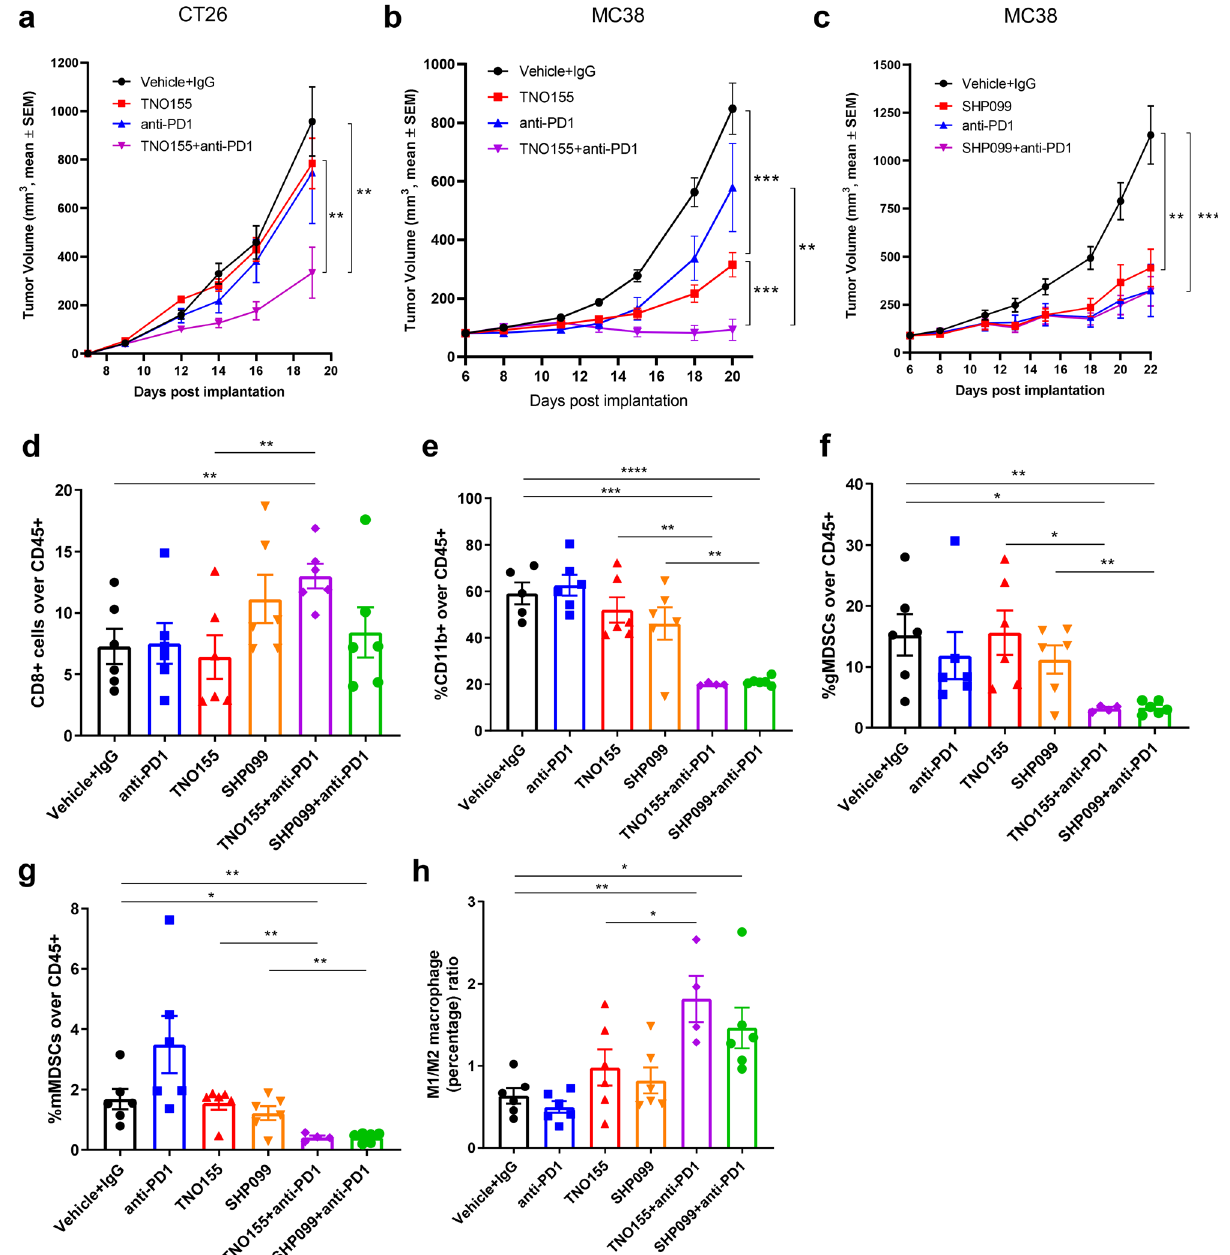
Figure 9. SHP2 inhibition displays combination benefit with PD1 blockade. ( a ) Tumor growth curve (expressed as tumor volume) of subcutaneous CT26 tumors in CT26 syngeneic mice with different treatments. TNO155: 20 mg/kg, PO, BID; Anti-PD1: 10 mg/kg, IP, QW. ( b , c ) Tumor growth curve (expressed as tumor volume) of subcutaneous MC38 tumors in MC38 syngeneic mice with different treatments. Mice were treated with Vehicle + IgG, anti-PD1, TNO155 and TNO155 + anti-PD1 in ( b ); Mice were treated with Vehicle + IgG, anti-PD1, SHP099 and SHP099 + anti-PD1 in ( c ); TNO155: 20 mg/kg, PO, BID; SHP099: 100 mg/kg, PO, QD; Anti-PD1: 10 mg/kg, IP, QW. ( d ) Flow cytometry analysis of the percentage of CD8+ T cells over CD45+ immune cells in MC-38 syngeneic model. ( e ) Flow cytometry analysis of the percentage of CD11b+ myeloid cells over CD45+ cells in MC-38 syngeneic model. ( f ) Flow cytometry analysis of the percentage of gMDSCs over CD45+ cells in MC-38 syngeneic model. ( g ) Flow cytometry analysis of the percentage of mMDSCs over CD45+ cells in MC-38 syngeneic model. ( h ) Flow cytometry analysis of the percentage ratio of M1 macrophage over M2 macrophage in MC-38 syngeneic model. Flow cytometry data was analyzed and processed with FlowJo (Version 10.7.1, https ://www.flowj o.com/solut ions/flowj o/downl oads/previ ous-versi